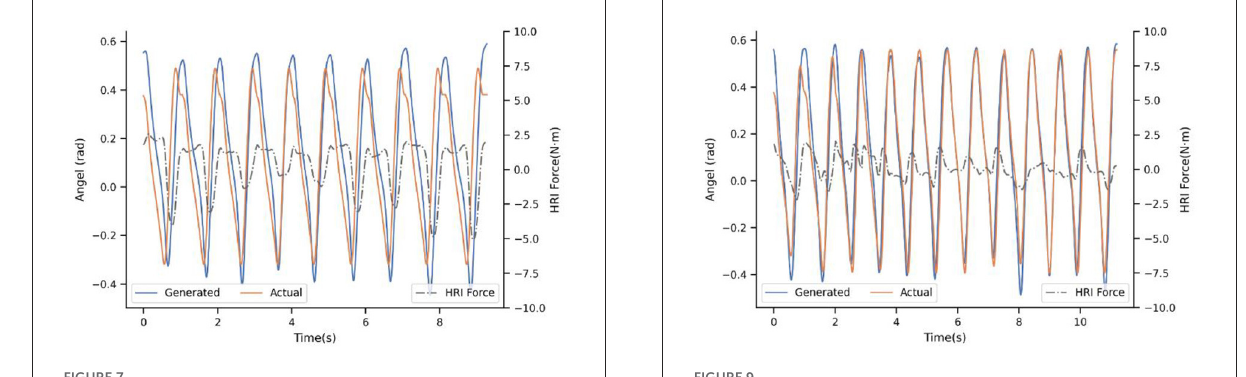
FIGURE7 Experimental results of subject 4 # with strategy P-I.